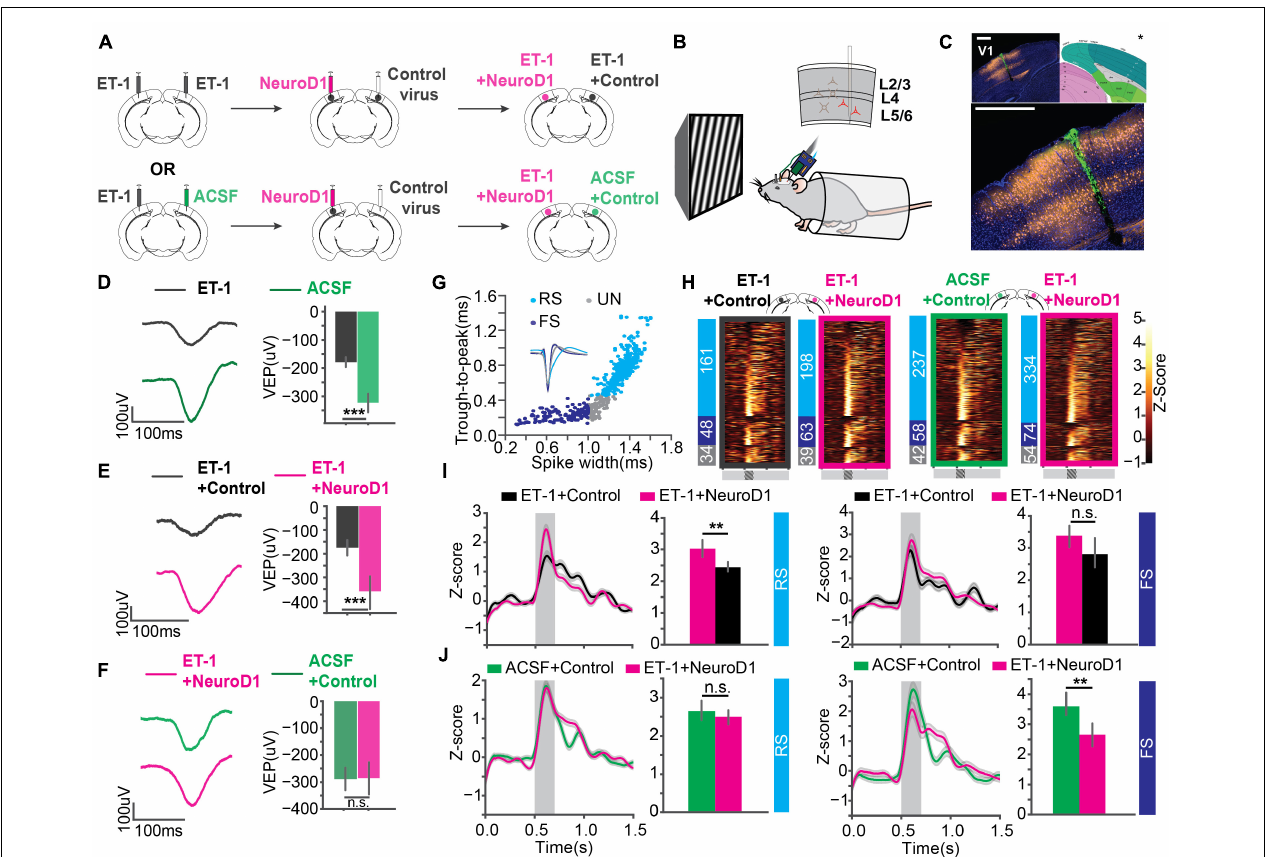
FIGURE 3 | In vivo direct reprogramming recovers visually evoked potentials (VEPs) and single unit visual responses. (A) The injection scheme for in vivo experiments. (B) The in vivo awake extracellular recording setup. (C) Histology showing the probe track (green) within the reprogramming site. NeuroD1: orange, DAPI: blue. *The brain atlas is adapted from ©Allen Institute for Brain Science. Allen Adult Mouse Atlas. Available from: atlas.brain-map.org. Scale: 500 µ m (top and botom). (D) Averaged VEPs of ET-1 and ACSF hemispheres. Quantification of VEP amplitudes on the right in each panel. N 1 = N 2 = 27 recording sites, 9 mice, p = 3.07 × 10 − 4 , Mann-Whitney U -test. (E) Same as (D) but for ET-1+Control and ET-1+NeuroD1 hemispheres. N 1 = N 2 = 33 recording sites, 11 mice, p = 1.30 × 10 − 5 , Mann-Whitney U -test. (F) Same as (D) but for ACSF+Control and ET-1+NeuroD1 hemispheres. N 1 = N 2 = 30 recording sites, 10 mice, p = 0.559, Mann-Whitney U -test. (G) Units classified into regular-spiking (RS), fast-spiking (FS), and unclassified (UN) units. Scatter plot showing trough-to-peak latency and waveform width of the units. The averaged template waveforms shown in the inset. (H) Firing rate z-scores of all units in heatmaps for “ET-1+Control vs. ET-1+NeuroD1” and “ACSF+Control vs. ET-1+NeuroD1” groups. The numbers of RS, FS, and UN units are shown on the left for each heatmap. (I) Left: Firing rate z-scores of RS units in the “ET-1+Control vs. ET-1+NeuroD1” group. The shaded area: visual stimulation. Bar graph showing peak z-scores within the visual stimulation window. N ET − 1 + Control = 161 units, 11 mice, N ET − 1 + NeuroD1 = 198 units, 11 mice, p = 1.56 × 10 − 3 , Mann-Whitney U -test. Right: Same as the left but for FS units. N ET − 1 + Control = 48 units, 11 mice, N ET − 1 + NeuroD1 = 63 units, 11 mice, p = 0.084, Mann-Whitney U -test. (J) Left: Firing rate z-scores of RS units in the “ACSF+Control vs. ET-1+NeuroD1” group. The shaded area: visual stimulation. Bar graph showing peak z-scores within the visual stimulation window. N ACSF + Control = 237 units, 10 mice, N ET − 1 + NeuroD1 = 334 units, 10 mice, p = 0.238, Mann-Whitney U -test. Right: Same as the left but for FS units. N ACSF + Control = 58 units, 10 mice, N ET − 1 + NeuroD1 = 74 units, 10 mice, p = 0.0058, Mann-Whitney U -test. * p < 0.05, ** p < 0.01, and *** p < 0.001, n.s., not significant. Data are represented as mean ± SEM.